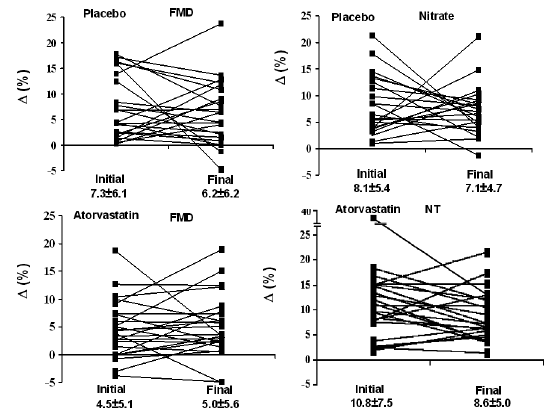
Figure 2 - Flow Mediated Dilation (FMD) and Nitrate dilation at pre- and post-treatment (4 weeks of placebo or low dose